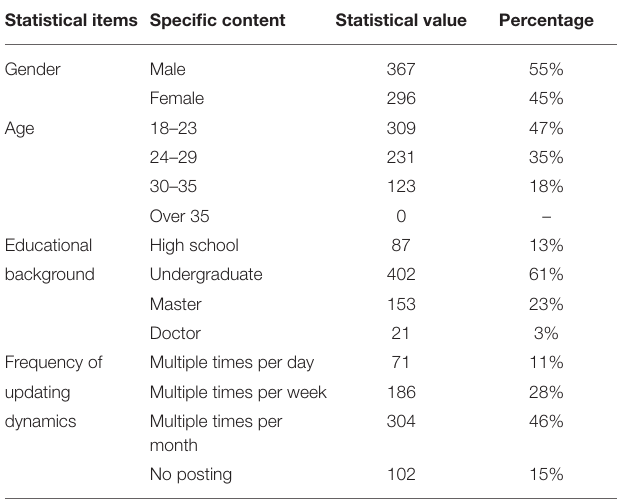
TABLE 1 | Statistical table of basic information of effective